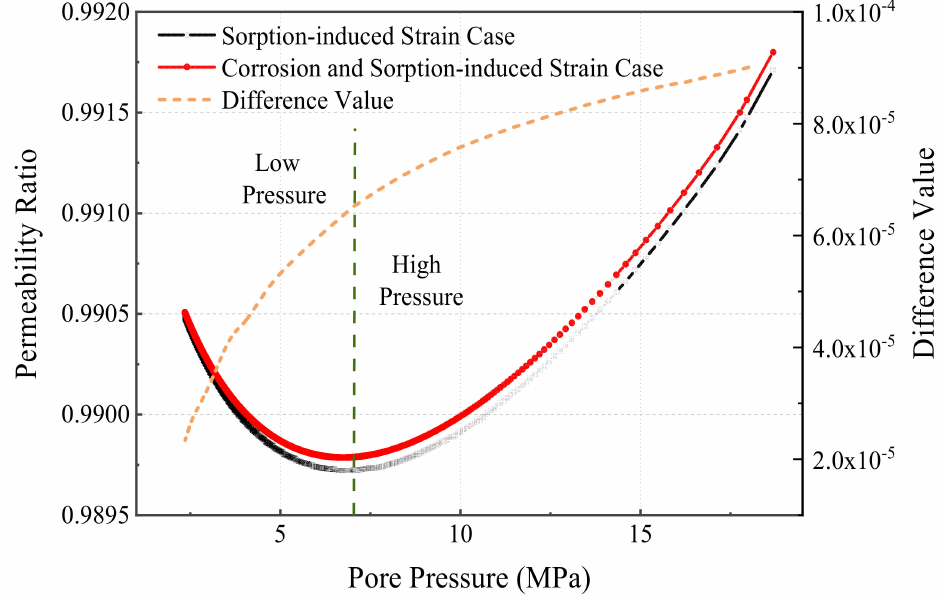
Figure 5. Permeability change curve of CO 2 -bearing oil shale considering sorption-induced strain case as well as corrosion and sorption-induced